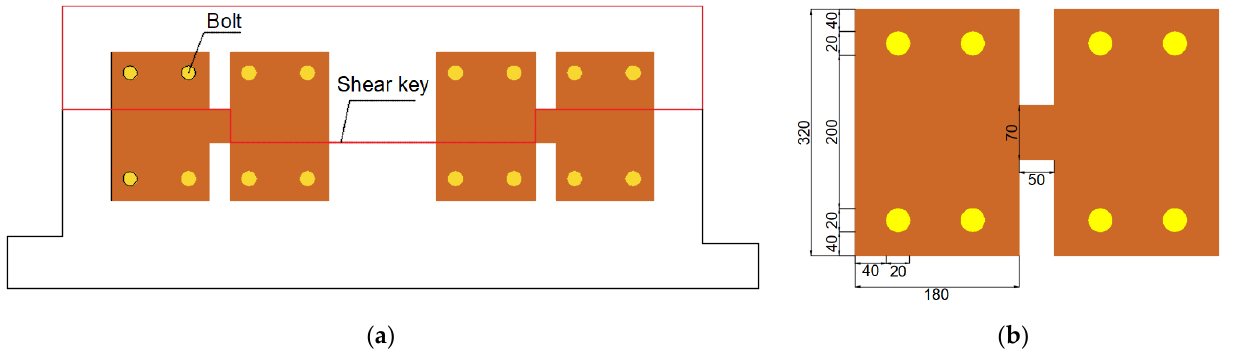
Figure 3. Schematic diagram of the energy absorption device: ( a ) Connection schematic diagram; ( b ) Dimension parameters of the energy absorption device. Table 1. Mechanical parameters of steel plate.